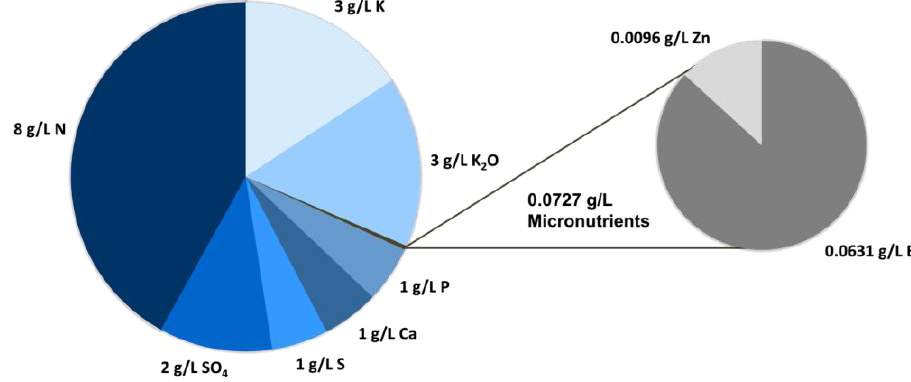
Figure 2. Nutrient composition of the aquaculture sidestream. Macro- and Micro-nutrients detected in an analysis of the untreated aquaculture sidestream performed by Eurofins Agraranalytik Deutschland GmbH. Nutrients below the detection limit are not represented.